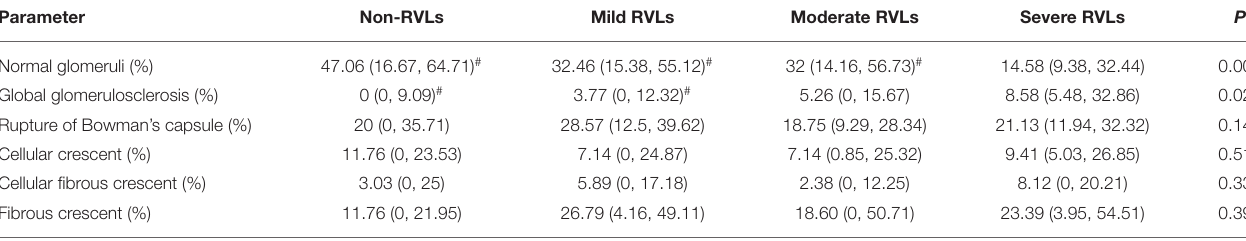
TABLE 3 | Pathologic characteristics of glomeruli of the non-RVL, mild RVL, moderate RVL, and severe RVL groups. Parameter